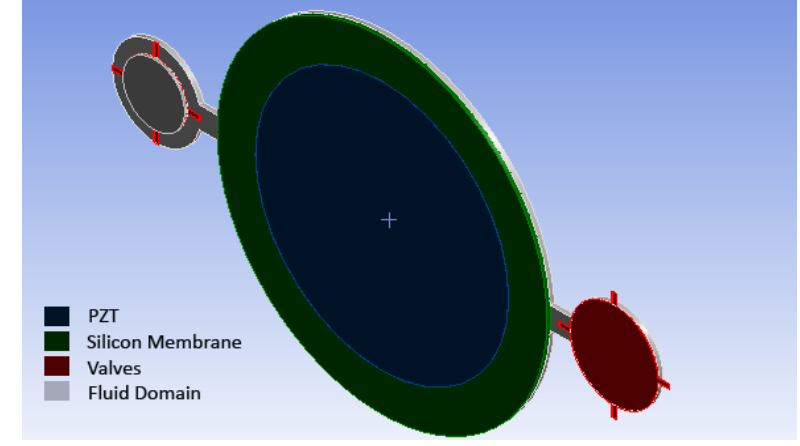
Figure 2. A 3-D scheme of the proposed